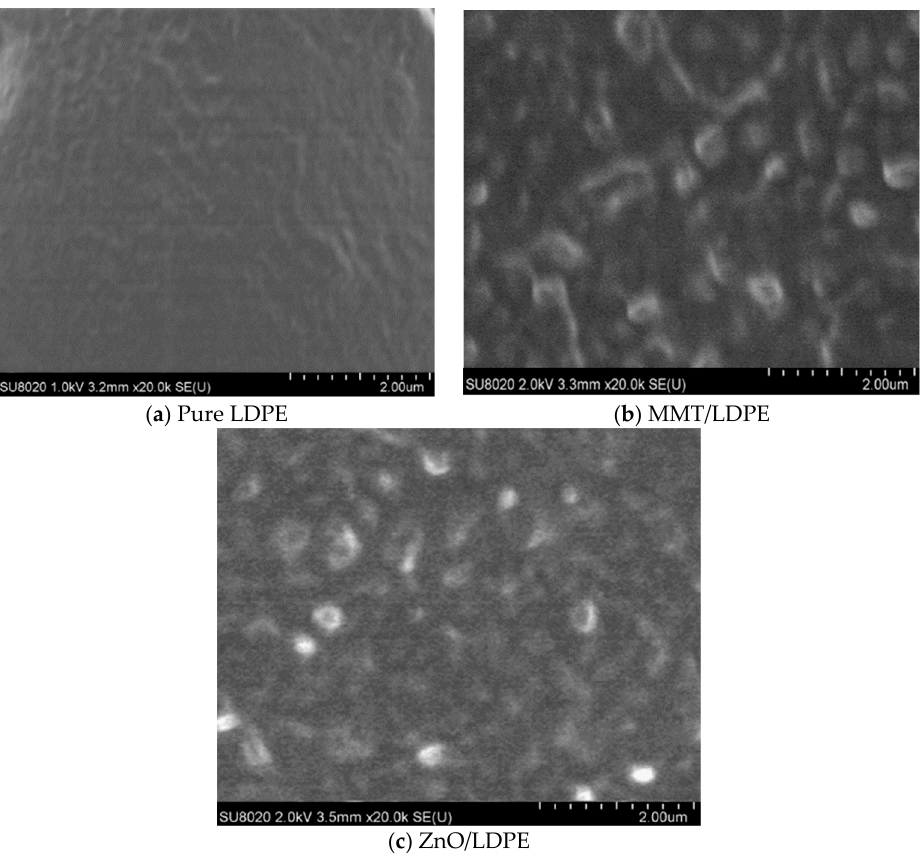
Figure 8. The SEM pictures of samples.